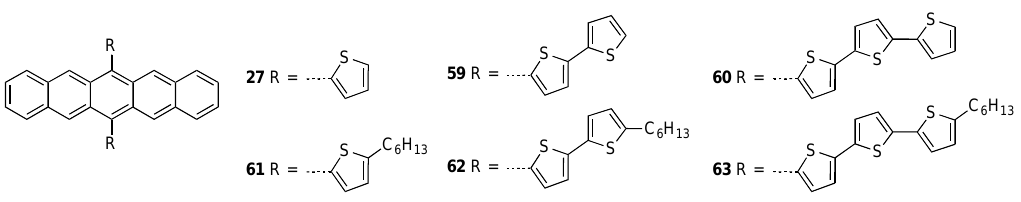
Figure 7. Structure of